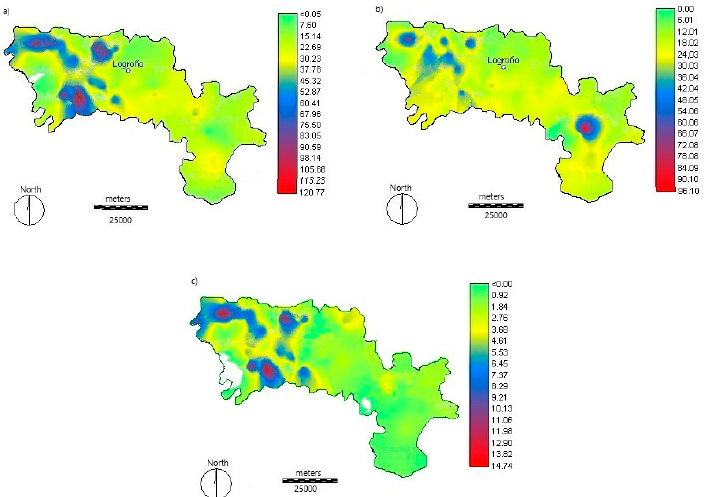
Figure 2. Spatial distribution content of Cu (arithmetic values in mg kg –1 ) observed in the vineyard soils of La Rioja: ( a ) total content in surface, ( b ) total content in depth, and ( c ) bioavailable content in surface.